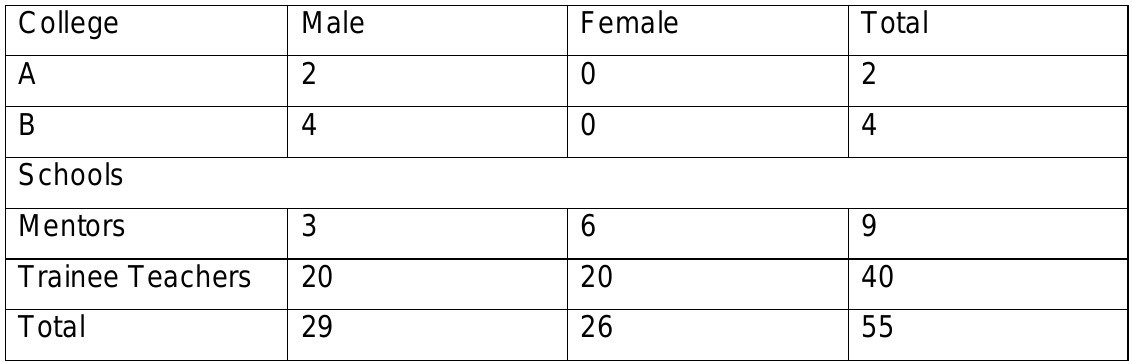
Table 3.4: Research target